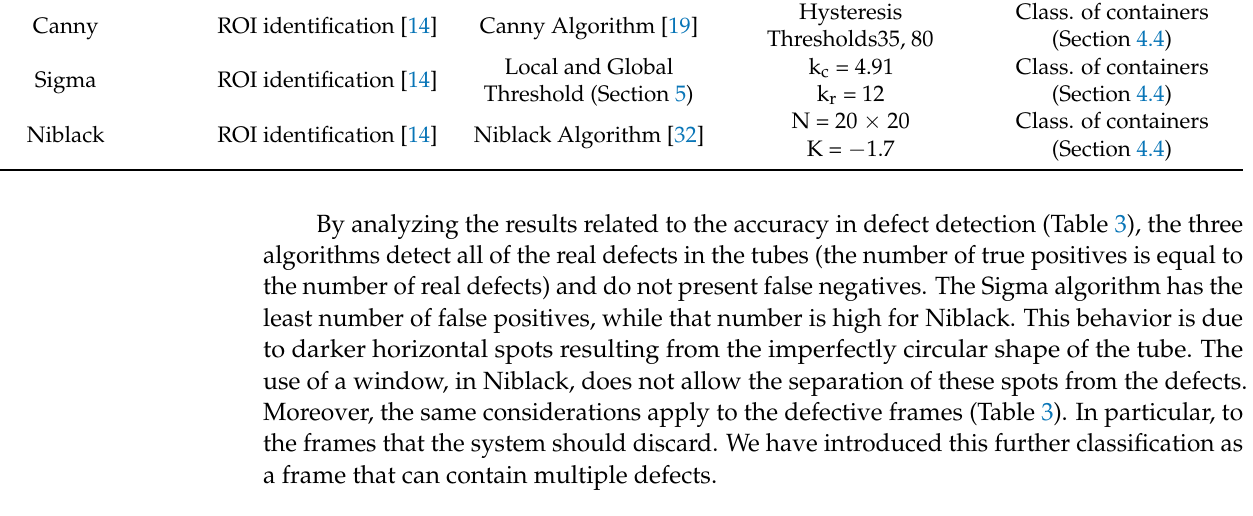
Table 3. Defects/defective frames and